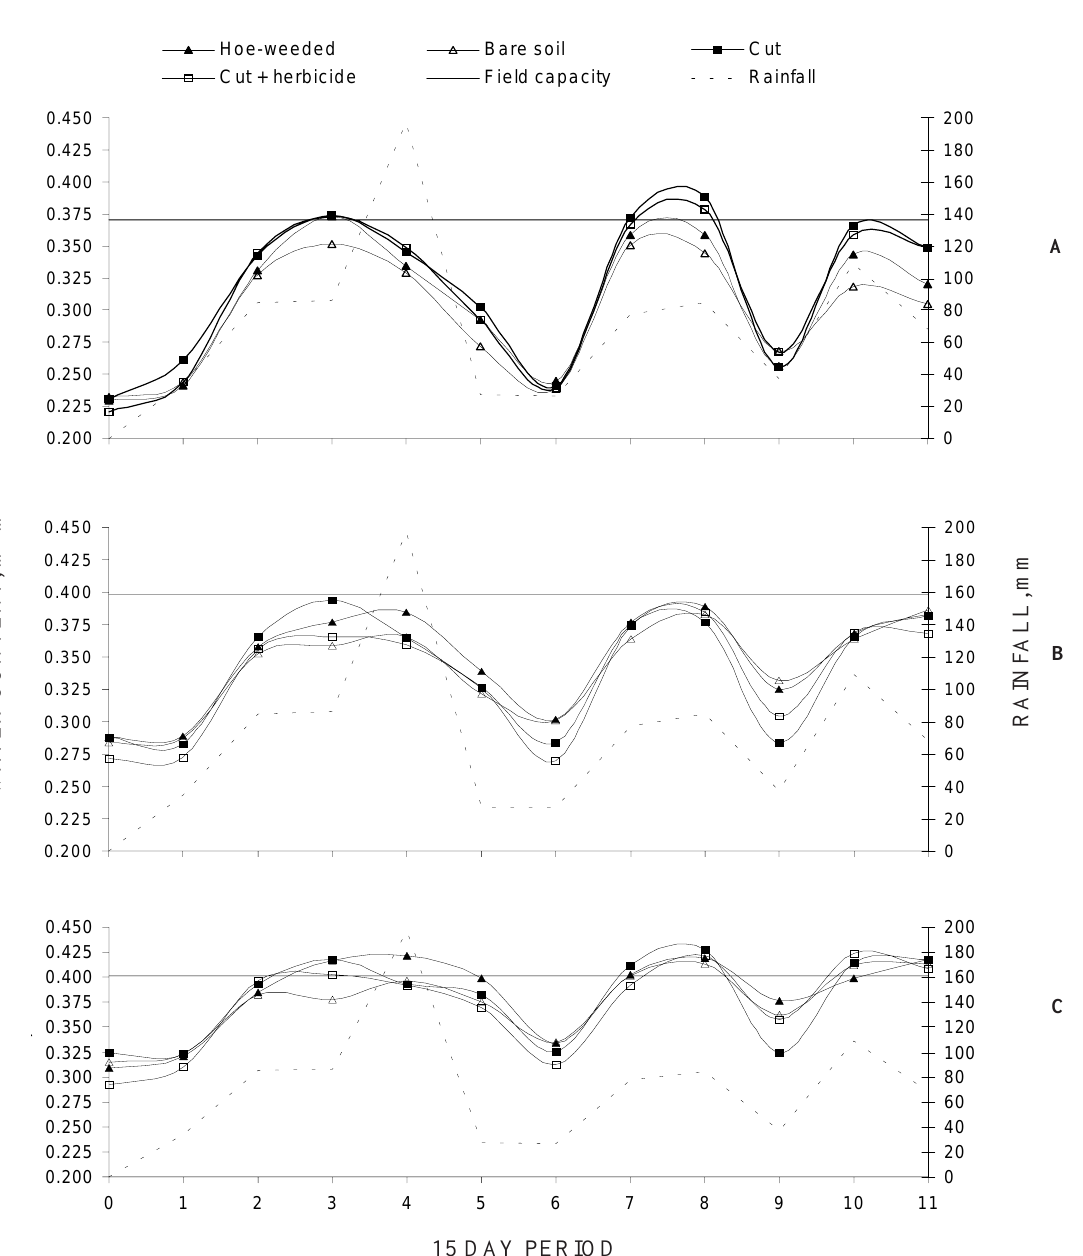
Figure 1. Water content at A: 10, B: 20 and C: 30 cm depth. Dotted line indicates rainfall data accumulated